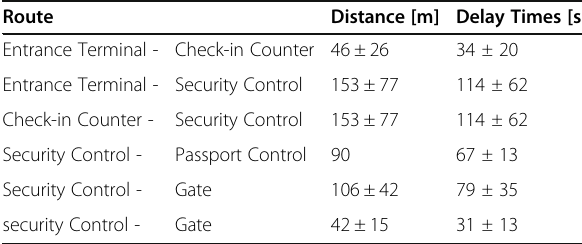
Table 2 Distances between the process stations and the resulting times the passengers need tocover these distances (delay times) for the model. The distances as well as the delay times are indicated by the mean value and the standard